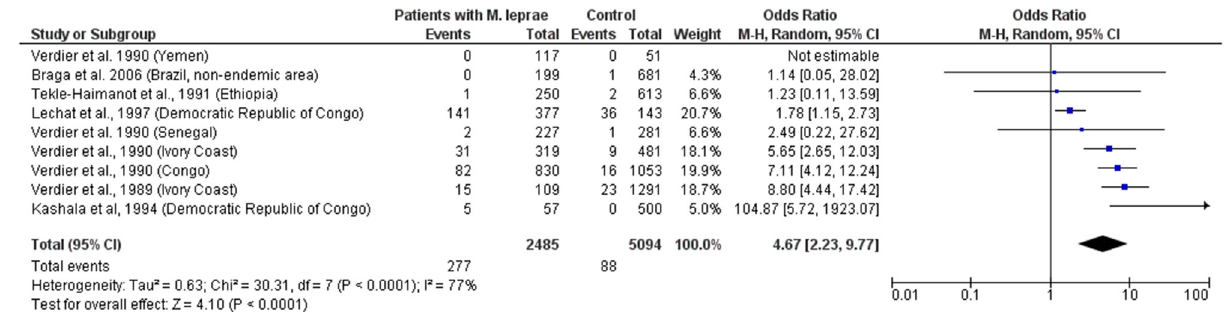
is associated with mucosal disruption and increased risk of HTLV-1 infection or is only a surrogate marker of unsafe sexual activity is unclear.